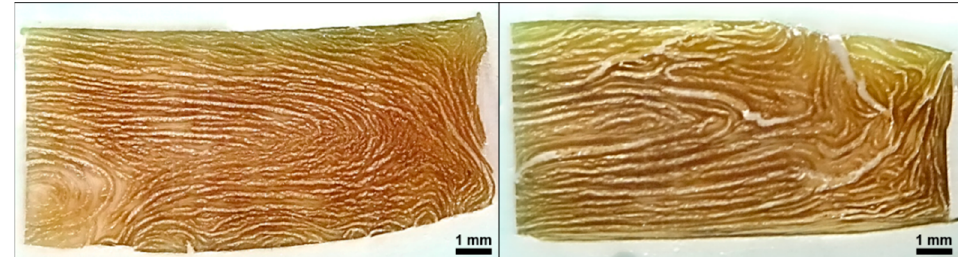
Figure 7. Microstructures of frozen extrudates of SPI extruded at 50% ( w/w ) moisture content and material temperatures of 124 °C ( left ) and 135 °C ( right ) before entering the cooling die. The front view is displayed. Extrudates are embedded in sectioning media.